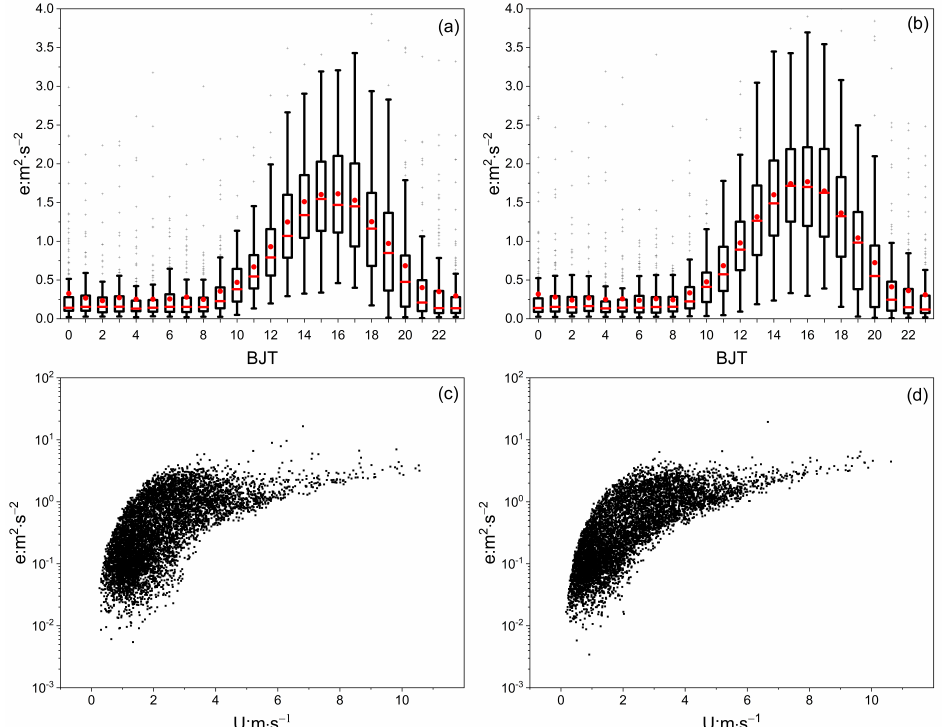
Figure 6. Diurnal variation of turbulent kinetic energy e in the PV plant ( a ) and the reference site ( b ). The height of the box shows the range from the 25th to 75th percentile. The horizontal red line inside the box and solid red dot denote the median value and mean value, respectively. The ends of the whiskers are drawn to the 10th and 90th percentile values. The relationship between turbulent kinetic energy and wind speed for the PV plant ( c ) and the reference site ( d ), U is the horizonal wind